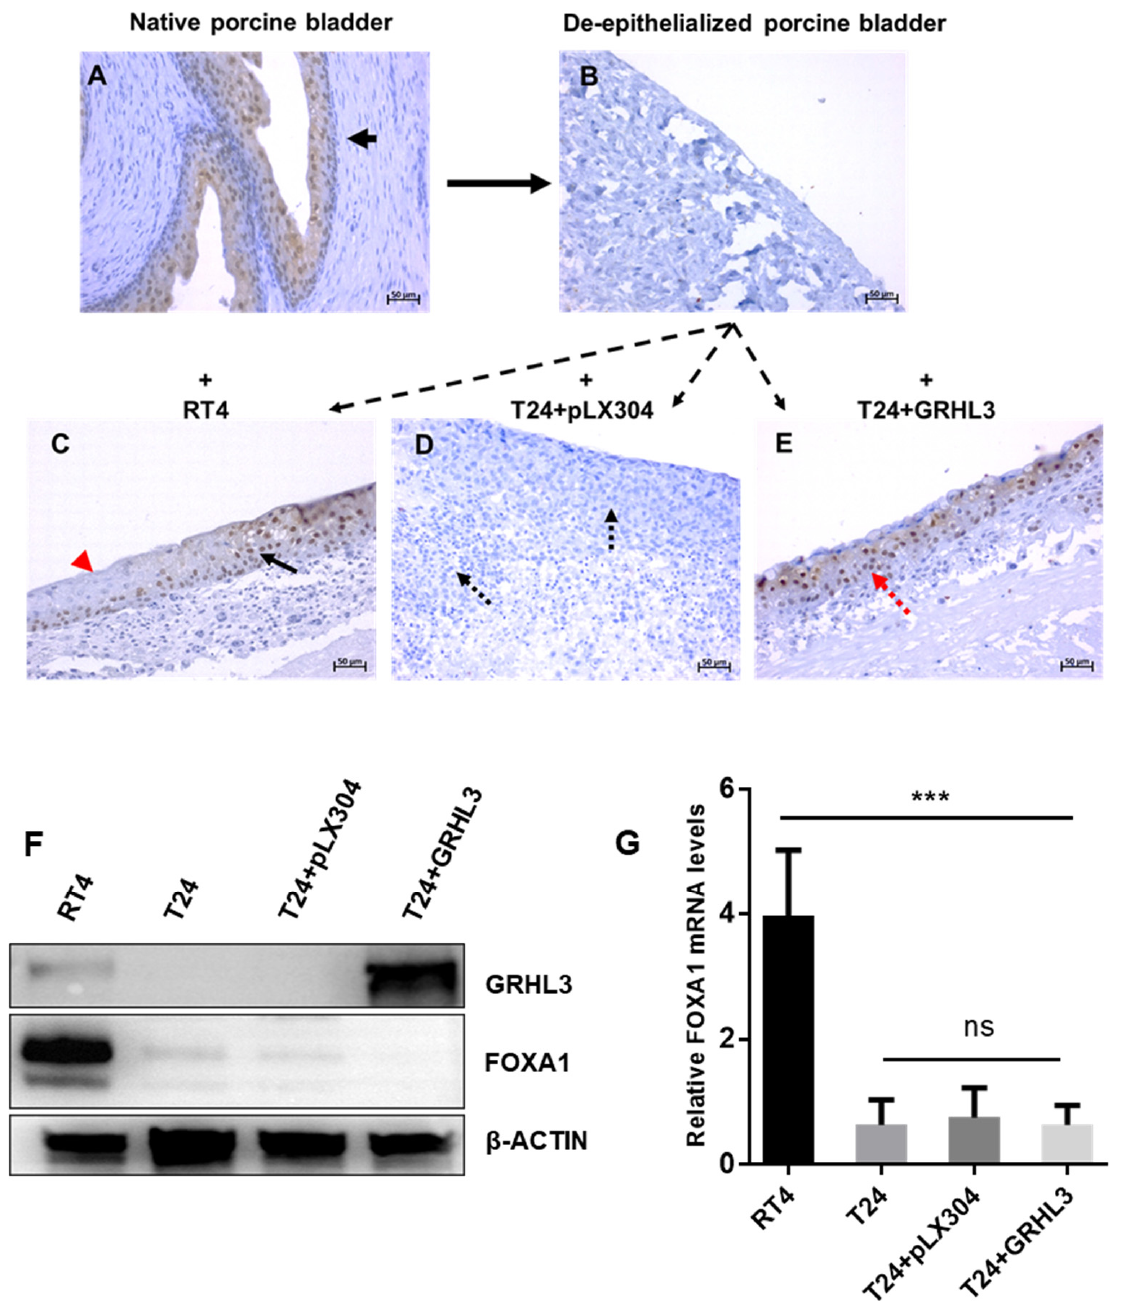
Figure 7. Ectopic expression of GRHL3 drives T24 cells towards a more differentiated phenotype when cultured in organ culture conditions allowing cell–stroma interactions. ( A ) Native porcine urothelium expresses FOXA1 in organ culture. ( B ) De-epithelialized porcine bladder was used as s negative control. ( C ) RT4 cells seeded on the de-epithelialized porcine bladder form a multi-layered epithelial lining. Not all cells are FOXA1-positive (red arrow), indicating partial differentiation. ( D ) T24+pLX304 cells invade into the porcine bladder stroma and muscle and lack FOXA1 expression (black dotted arrows). ( E ) GRHL3-expressing T24 cells do not invade and express FOXA1 (red dotted arrow). ( F ) Western blot shows FOXA1 protein expression only in RT4 but not in T24 cells, irrespective of ectopic GRHL3 expression when grown in 2D culture conditions. ( G ) Similarly, FOXA1 expression in 2D cell culture is not upregulated in T24 + GRHL3 cells. *** indicates p-value < 0.001; ns = not significant.